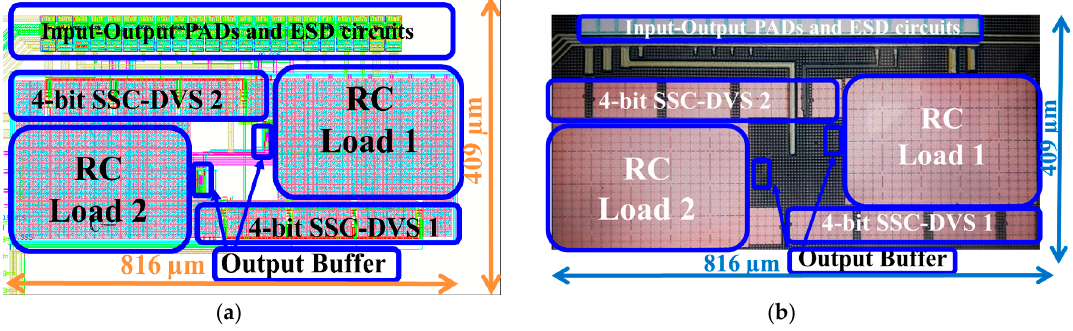
Figure 16. ( a ) Layout and ( b ) die micro-photograph of the proposed SSC-DVS architecture.